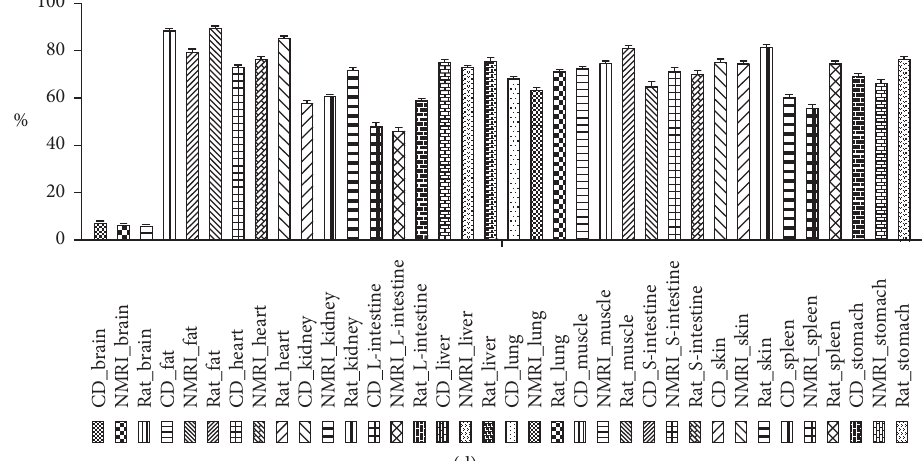
Figure 4: Percentage contribution of (a) acyl chain FA(22 : 6) in PC, (b) acyl chain FA(22 :6) in PG, (c) acyl chain FA(18:3) in TG, and (d) acyl chain FA(18: 2) in CL in 12 organs/tissues of CD1 and NMRI mice and rats ( n � 9).